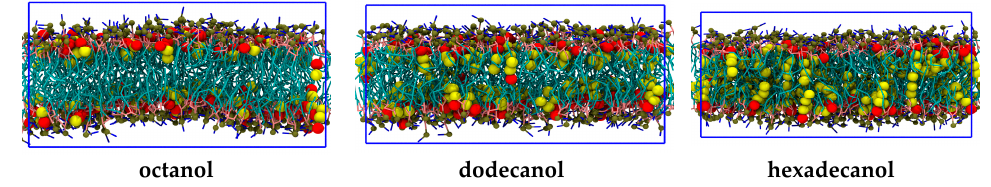
Figure 3. The coarse-grained molecular dynamics (MD) simulation snapshots of CnOH:DOPC = 0.3:1 bilayer systems. From left to right, the panels represent systems with octanol (C8OH), dodecanol (C12OH), and hexadecanol (C16OH). Alcohols are represented with large spheres colored in red for the polar OH head and yellow for alkane tails, while stick representation is utilized in the case of lipids (turquoise for chains, pink for glycerols, blue for choline, and green for phosphate). The blue rectangles delimit the periodic box, from which water is excluded for the clarity of presentation. The figure was produced with the Visual Molecular Dynamics (VMD) software [28].